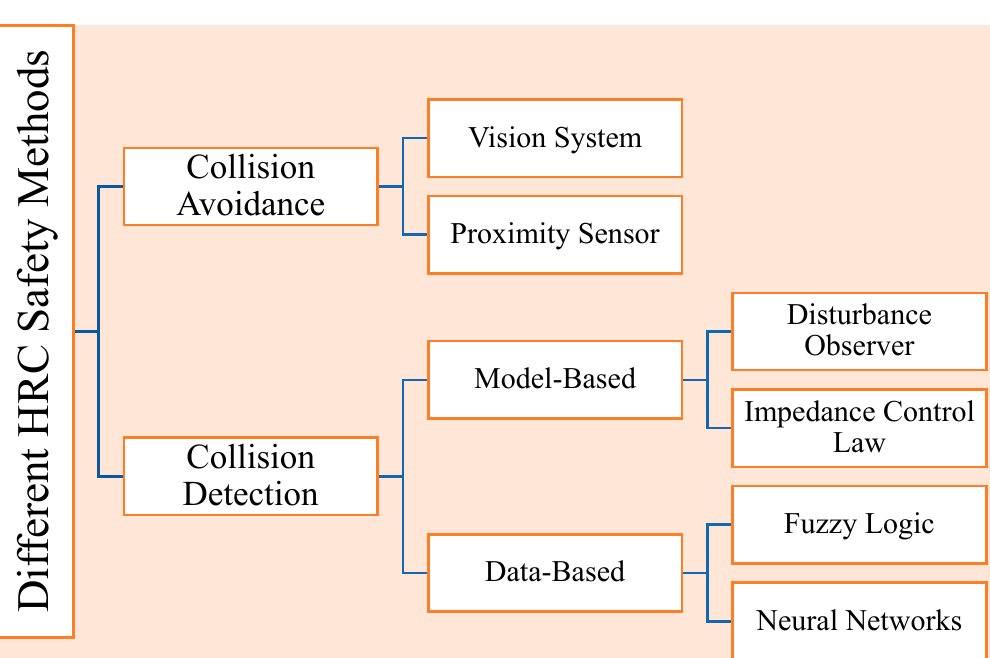
Figure 1. The classification of the safety methods of HRC.